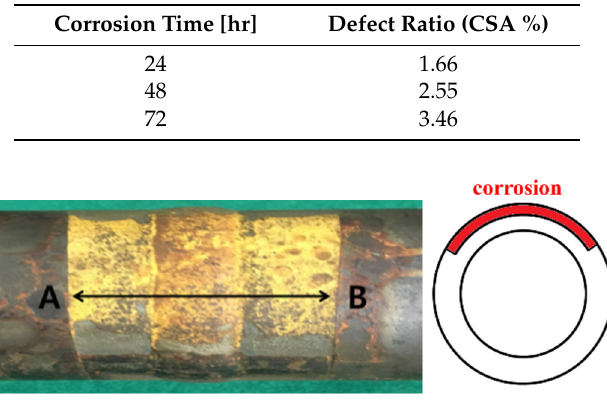
Table 2. Corrosion depths to pipe wall thickness and corrosion area to the CSA of pipe in the weld region.